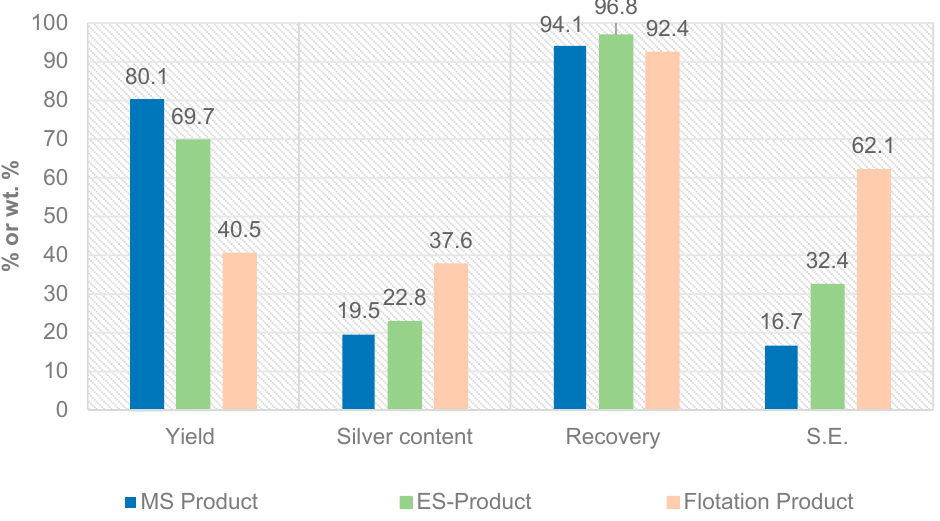
Figure 8. Comparison of the results of magnetic-, electrostatic separation and flotation (yield: mass output in relation to input, S.E.: separation efficiency).